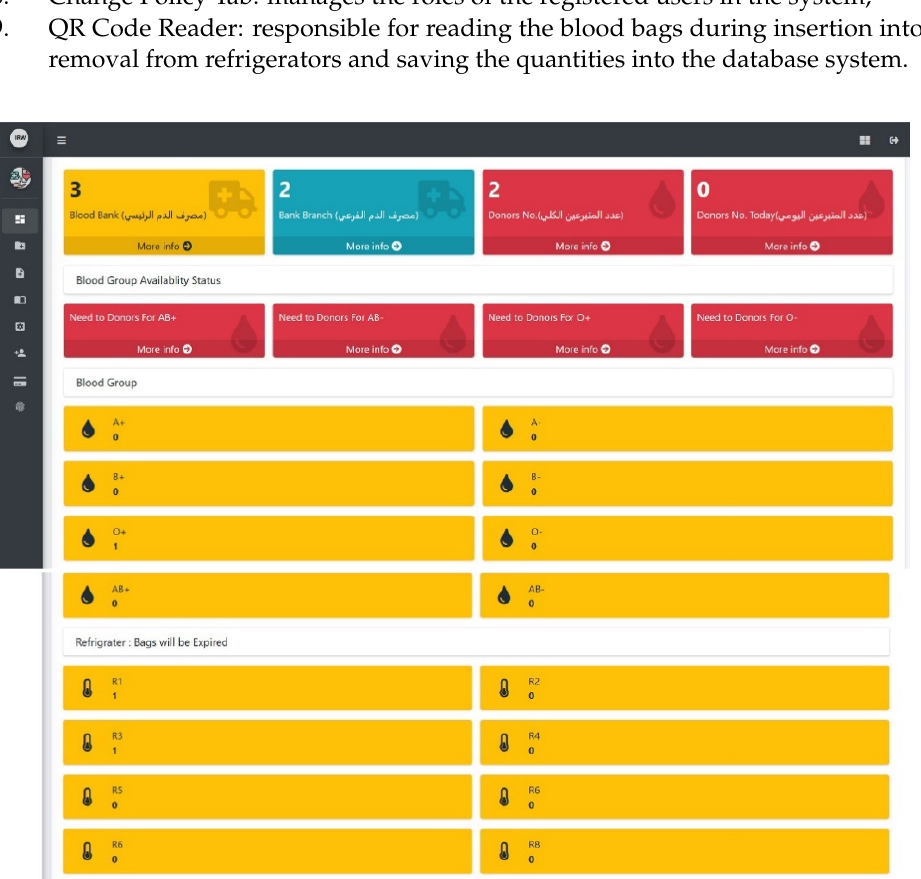
Figure 8. ESP8266 equipment.